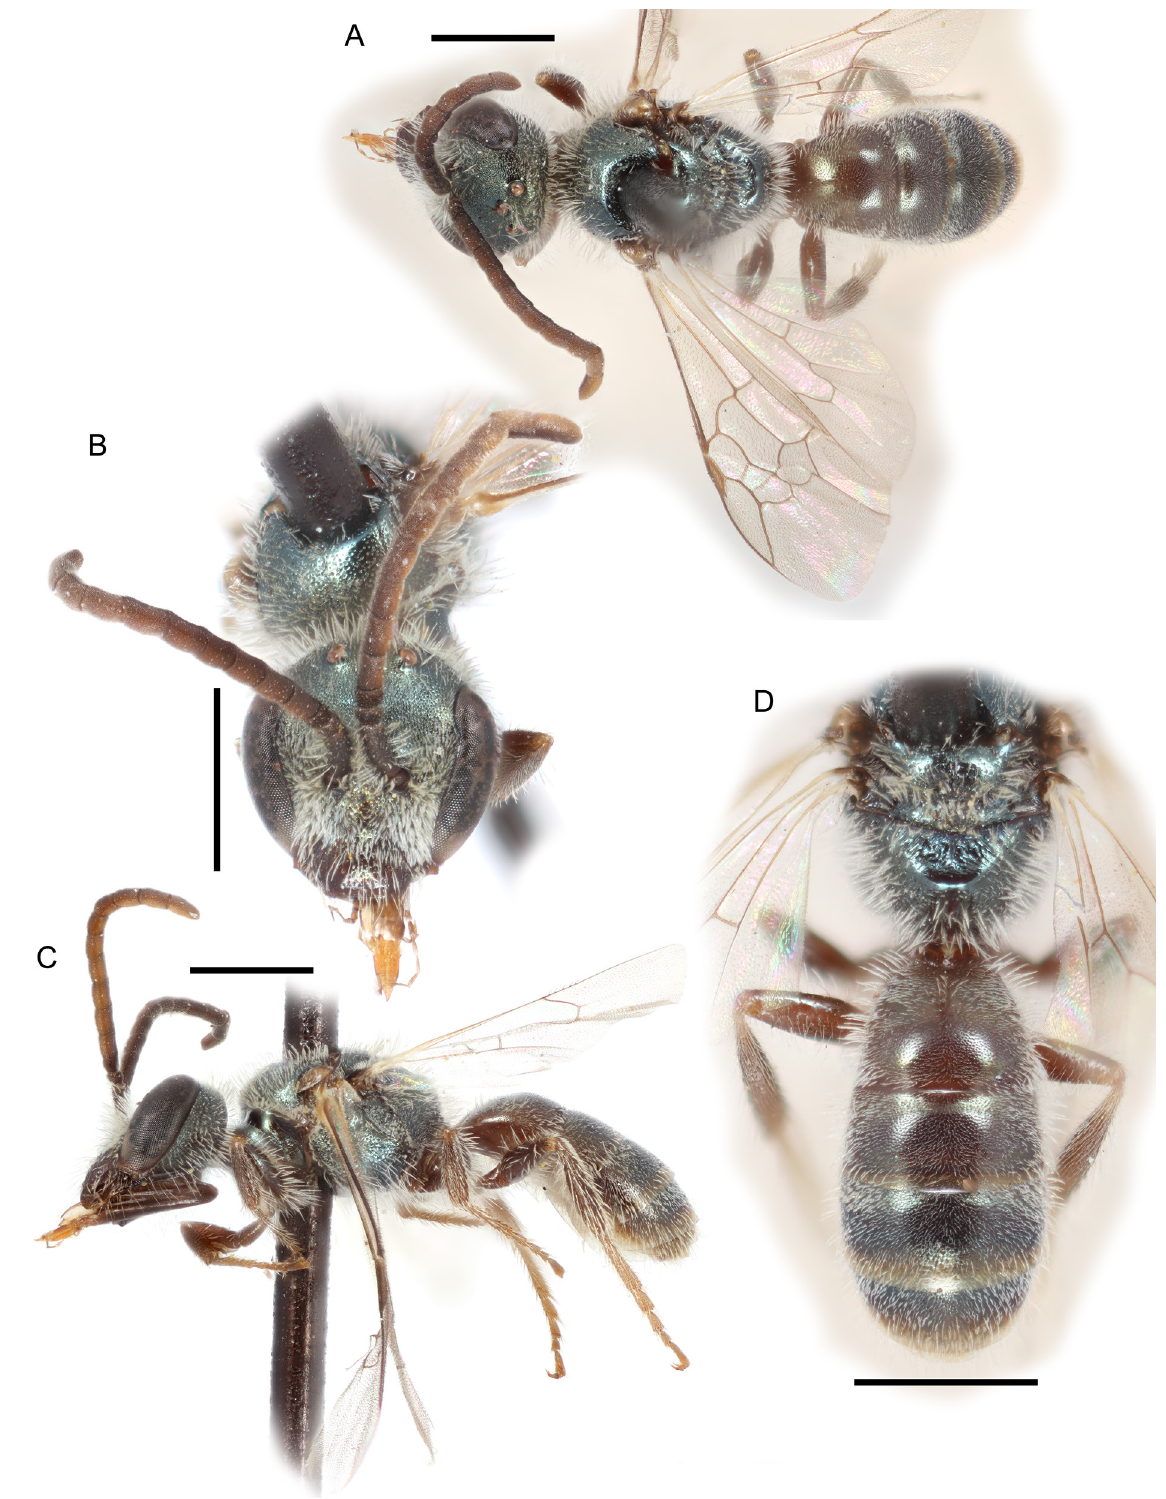
Fig. 20. Lasioglossum ( D. ) cembrilacus sp. nov., ♂. A . Dorsal habitus. B . Face. C . Lateral habitus. D . Propodeum and metasoma. Scale bars: 1